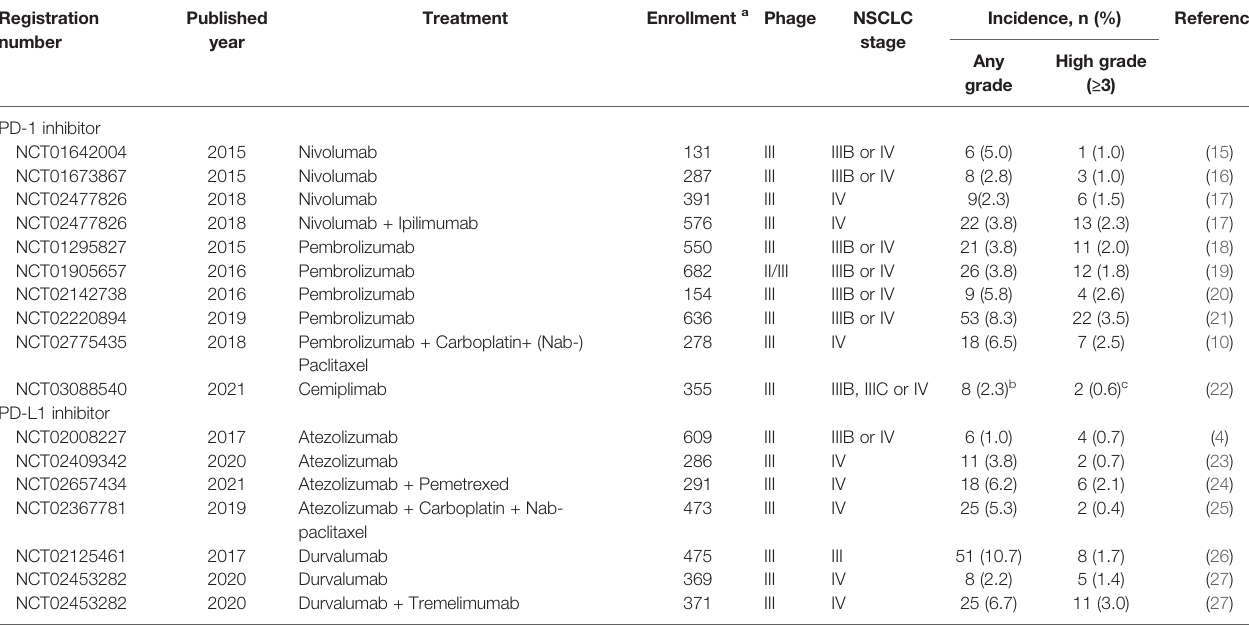
TABLE 1 | Important clinical trials that reported checkpoint inhibitor pneumonitis (CIP) in NSCLC patients with PD-1/PD-L1 blockade.